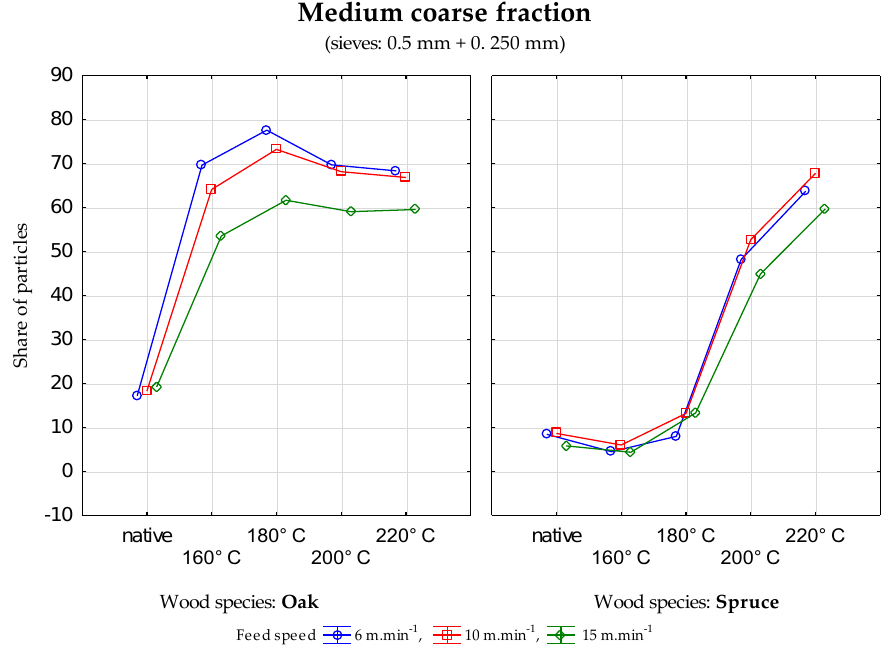
Figure 2. Percentage of particles in the mesh size of 0.5 mm and 0.250 mm—medium coarse fraction depending upon the temperature modification of oak and spruce.